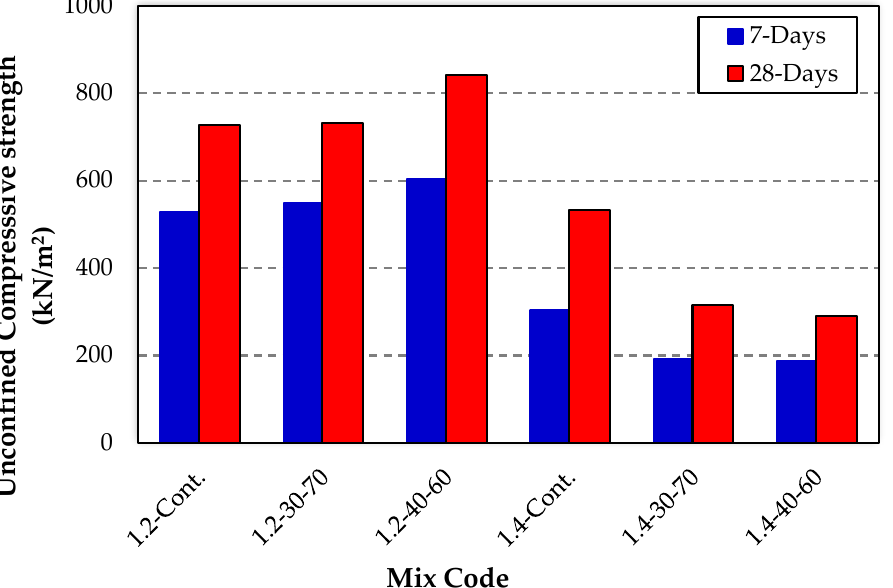
Figure 2. Unconfined 7- and 28-day compressive strength for various kaolinite clay cylinder speci- mens dosed with 6 wt.% gypsum and at varying OMCs.